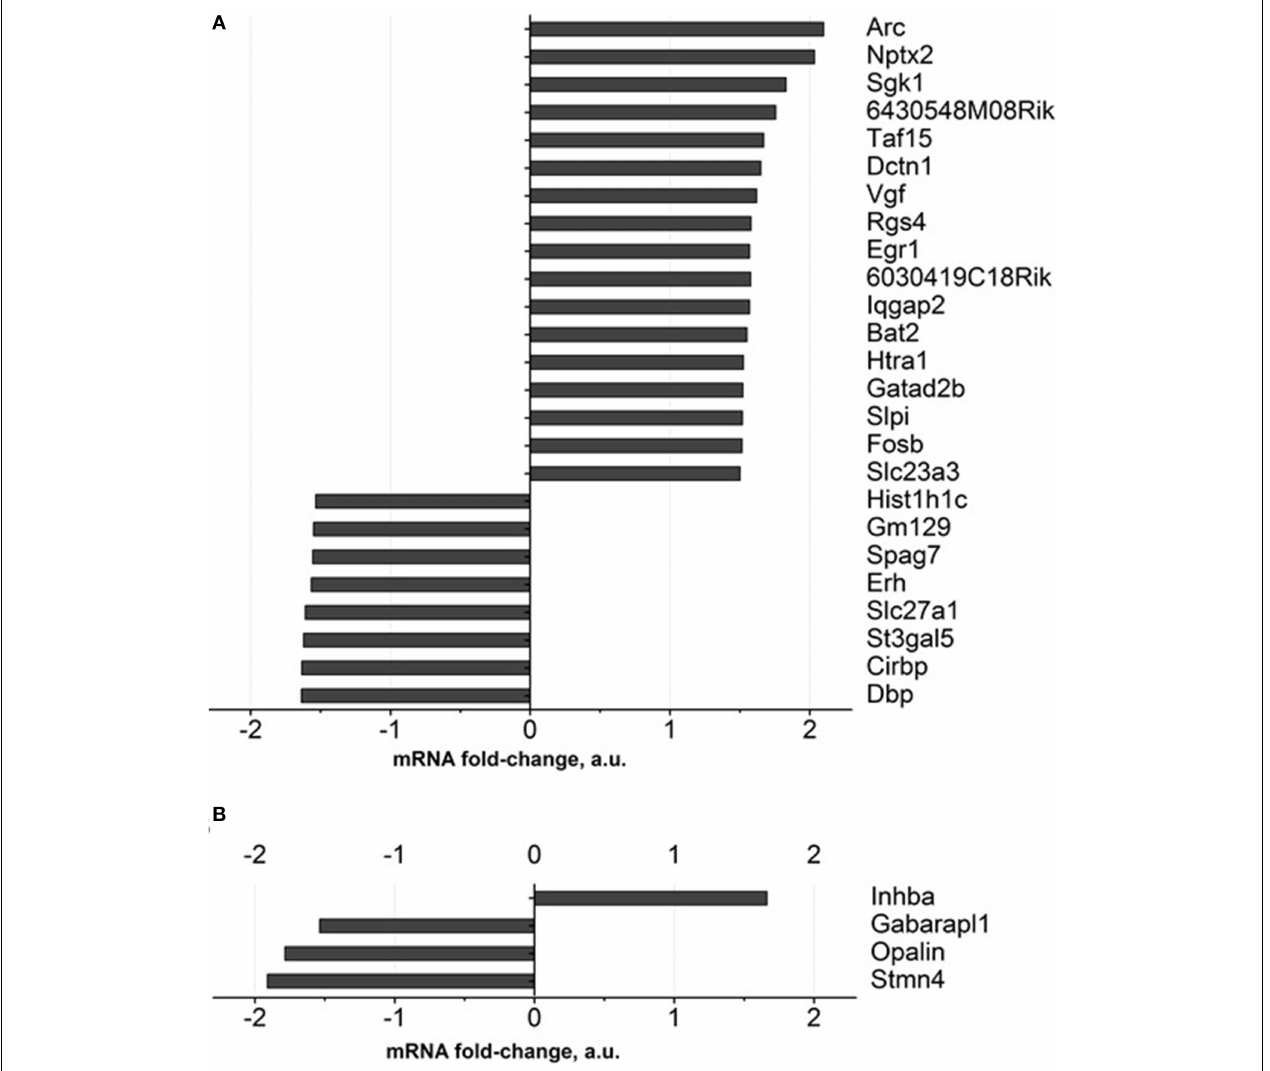
FIGURE 4 | Gene expression profiling of brain of old mice treated with Dicholine Succinate. A significant change in over 1.5 folds from vehicle-treated aged control as found with 27 genes in the (A) hippocampus and 4 genes in the ( B) prefrontal cortex. For the criteria of gene selection, see the text.